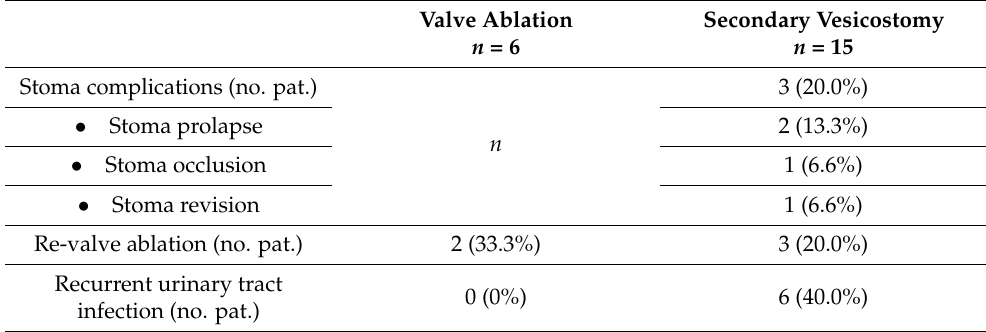
Table 4. Postoperative complications. Stoma complications (no. pat.)